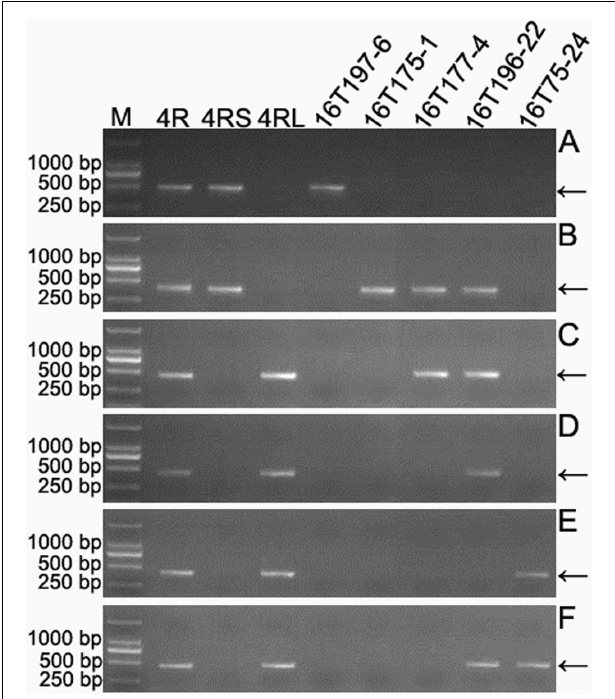
FIGURE 4 | Physically localized 4R Ku -specific markers using 4R Ku dissection lines. (A) Products amplified by primer pair KU.737. (B) Products amplified by primer pair KU-4R.115. (C) Products amplified by primer pair KU-4R.149. (D) Products amplified by primer pair KU-4R.563. (E) Products amplified by primer pair KU-4R.004. (F) Products amplified by primer pair KU.1058. Primer pairs KU.737, KU-4R.115, KU-4R.149, KU-4R.563, KU-4R.004 and KU.1058 respectively represent the markers that mapped to the six regions including I, II, III, IV, V, and the region cross IV and V. M: DNA marker. 4R: MA4R Ku . 4RS: MTA4RS Ku . 4RL: MTA4RL Ku . Arrows indicate the target